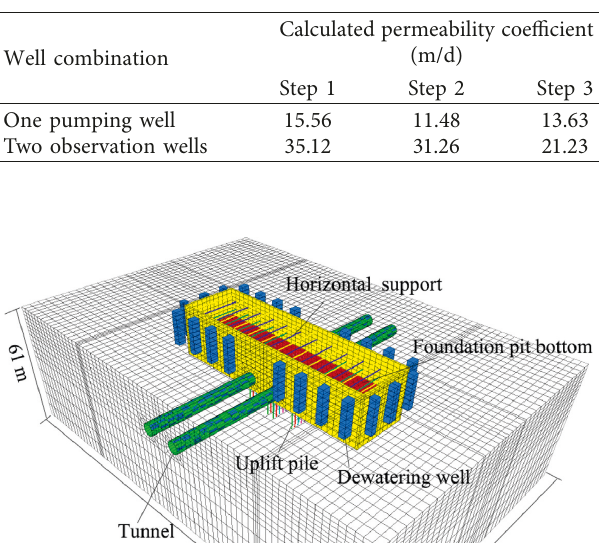
Table 4: Analysis and calculation results of two well